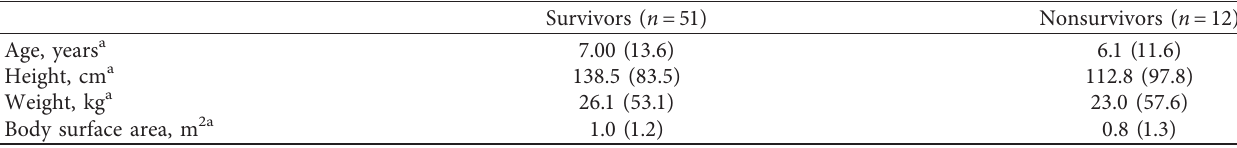
Table 1: Patient